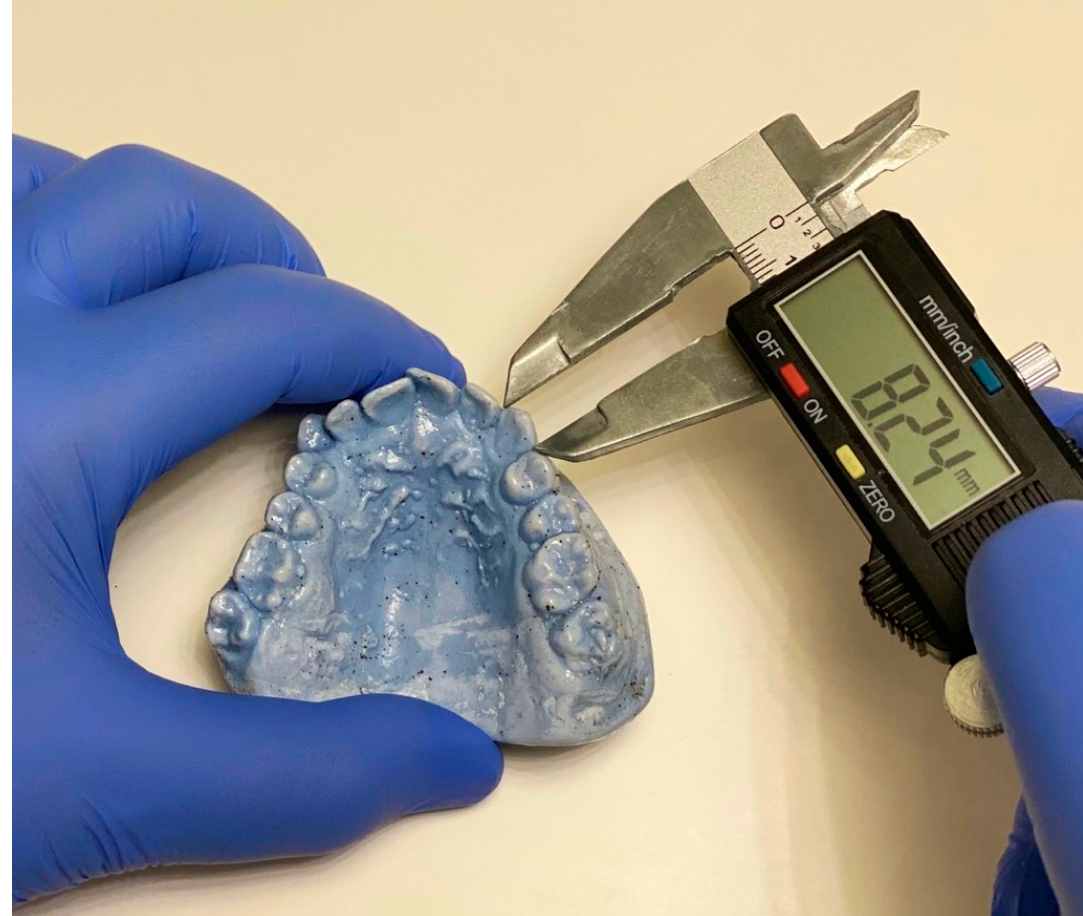
Figure 1. Digital caliper used in the study.